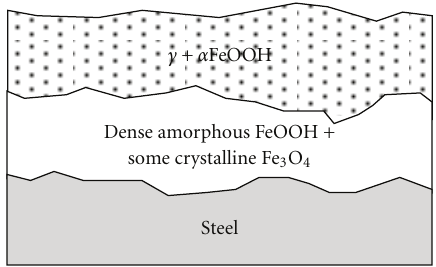
Figure 2: Dual nature of the rust